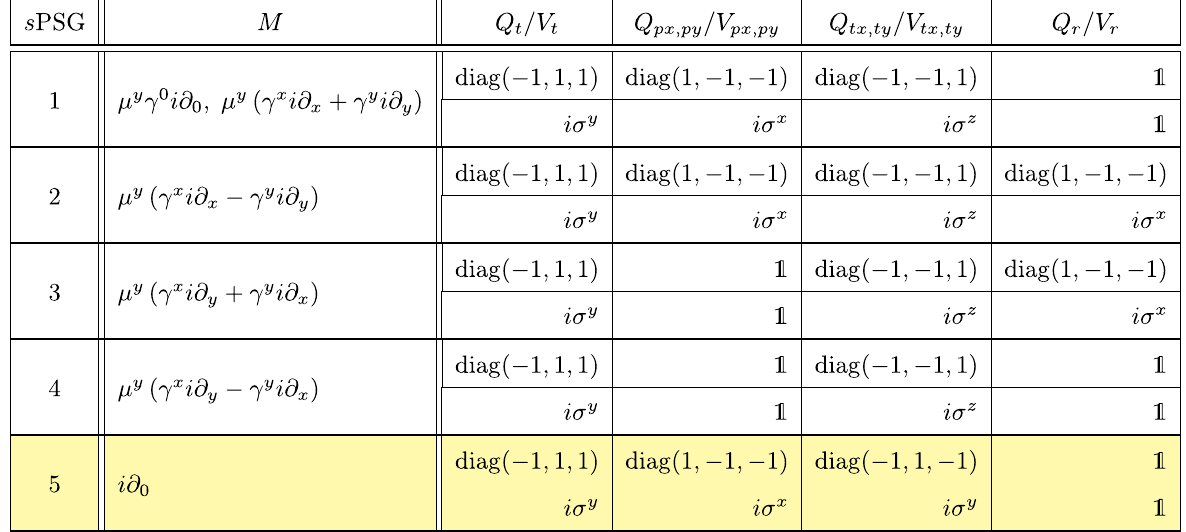
FIG. 6. All symmetric PSGs associated with symmetric Z 2 spin liquids in which h Φ x i ≠ 0 , where Φ couples to tr ð σ a listed as a function of the operator tr ð σ a